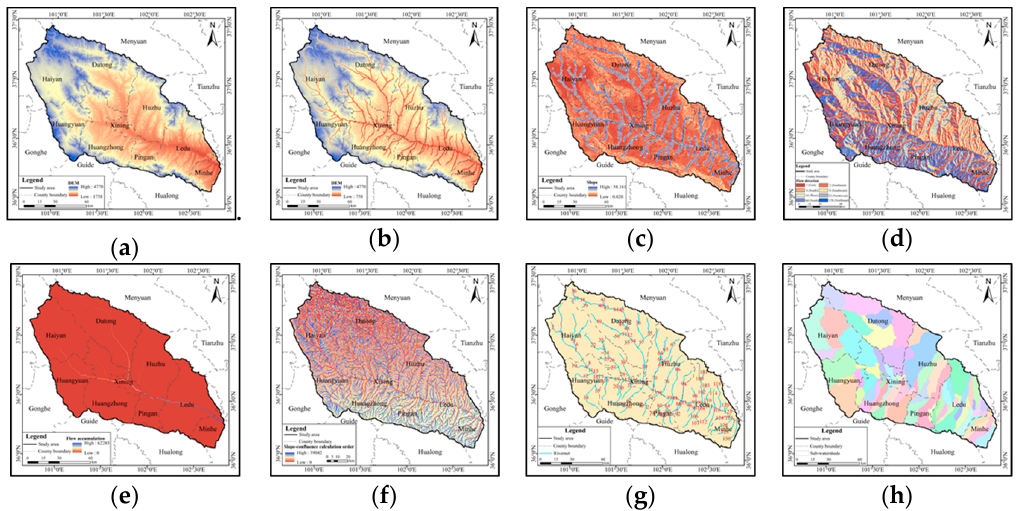
Figure 5. Sub-watershed and Slope-confluence calculation order formation processes (( a ) Digital Elevation Model (DEM); ( b ) revised DEM; ( c ) slope; ( d ) flow direction; ( e ) flow accumulation; ( f ) calculation order of slope confluence; ( g ) river code; ( h ) sub-basin).